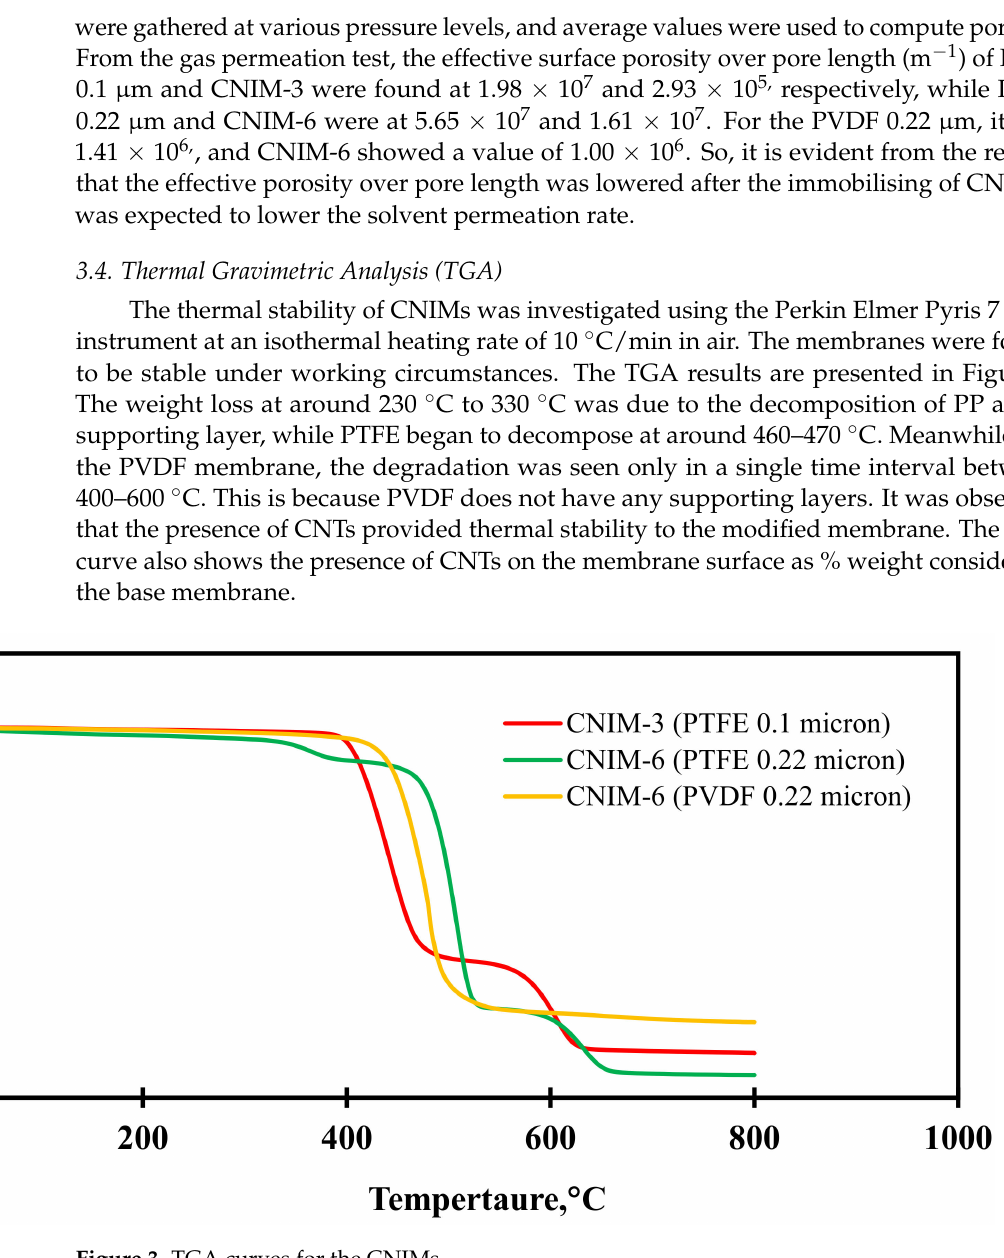
Figure 3. TGA curves for the